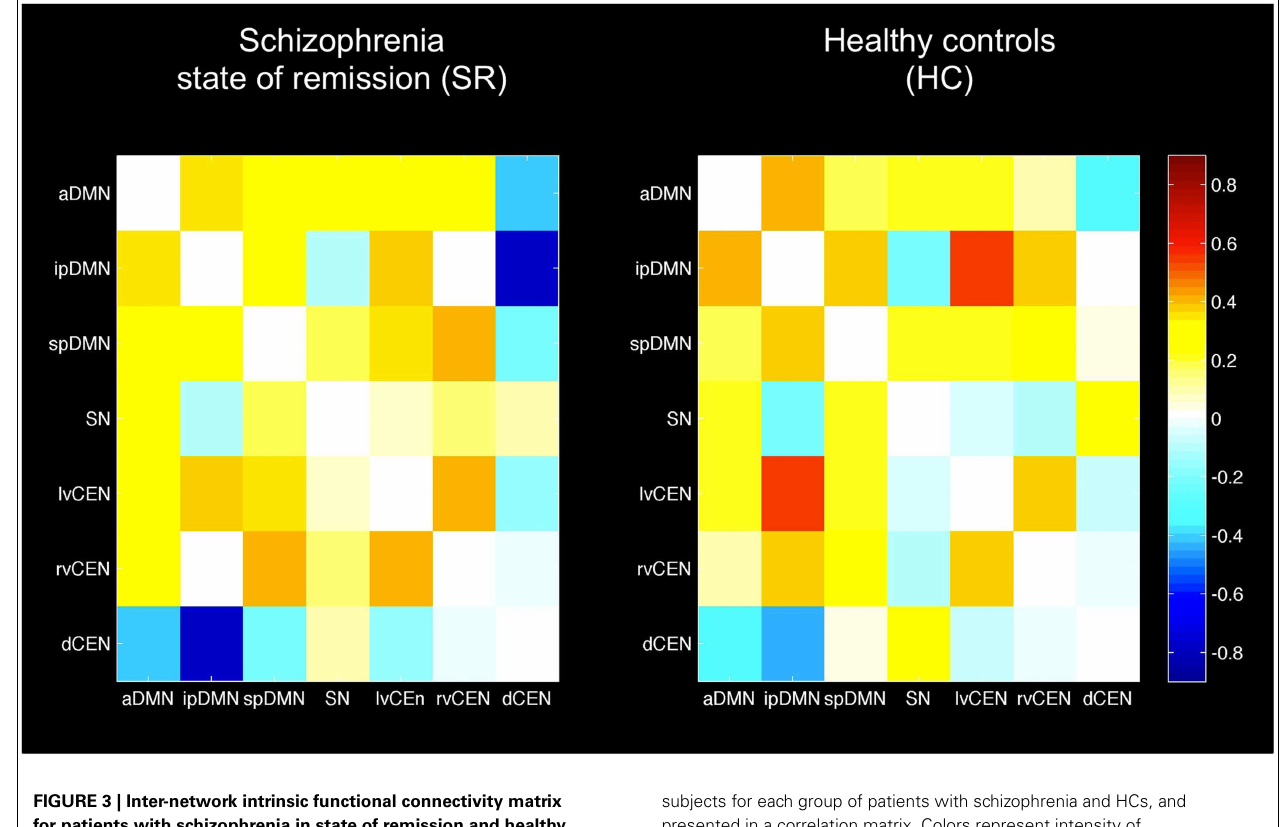
subjects for each group of patients with schizophrenia and HCs, and presented in a correlation matrix. Colors represent intensity of averaged z -scores. a/ip/spDMN: anterior/inferior-posterior/superior- posterior DMN; lv/rv/dCEN: left-ventral/right-ventral/dorsal CEN (see also Table 5